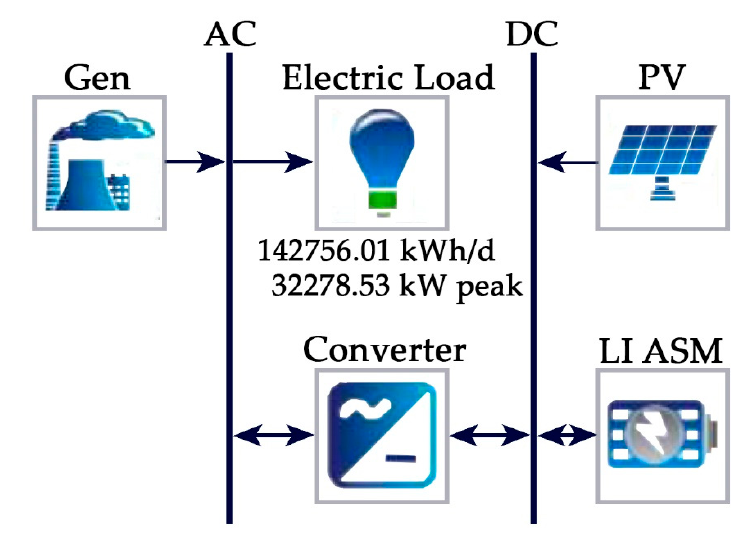
Figure 6. Scheme of the Hybrid mini-grid.